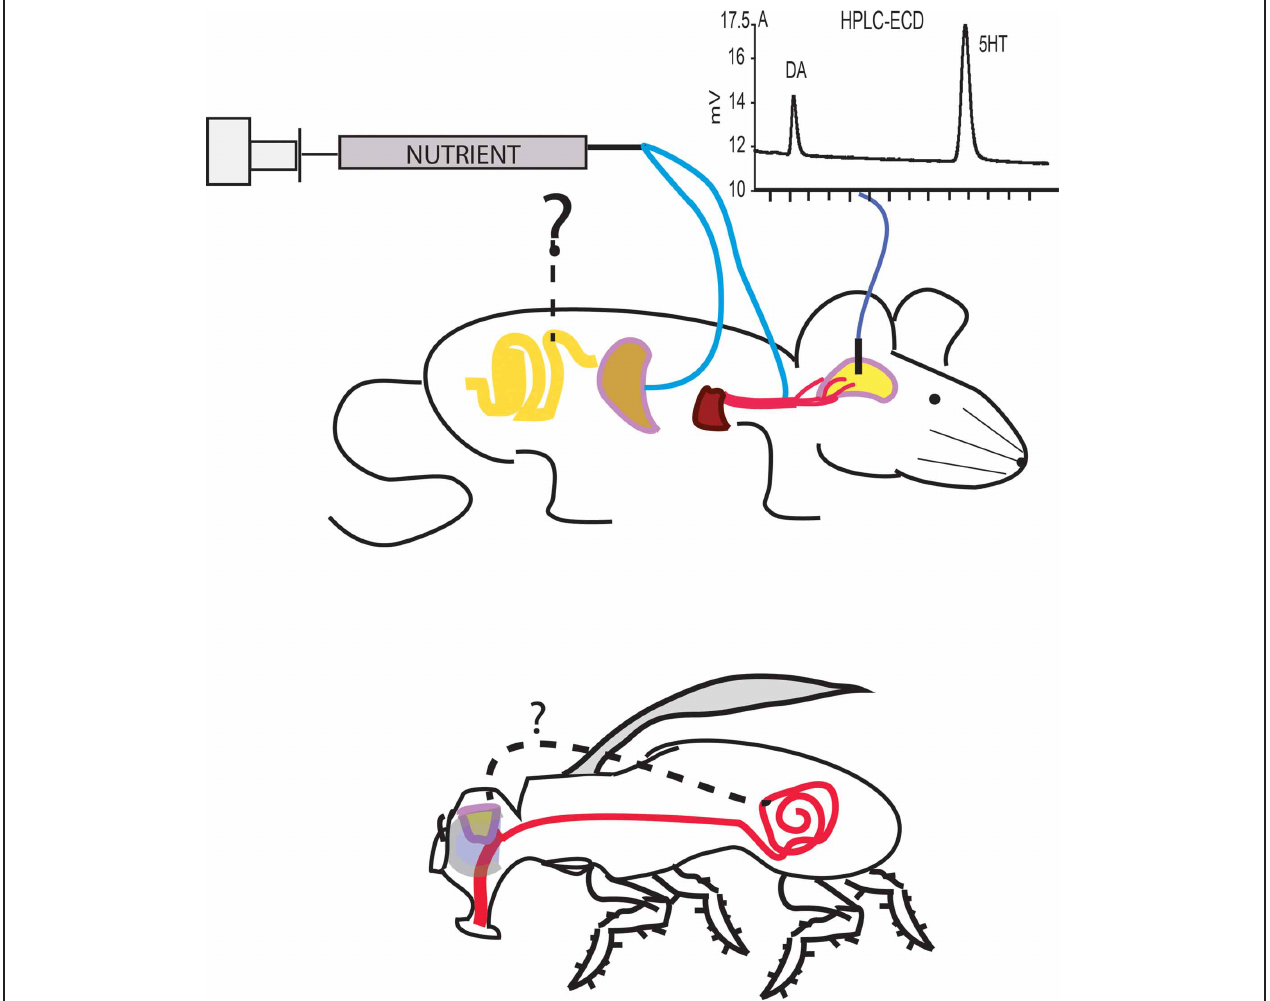
FIGURE 1 | Post-oral pathways modulating dopamine release. Infusions of nutrients into post-oral peripheral sites exert controlling actions over dopamine release, as measured from microdialysates collected from either the ventral or dorsal striatum. The figure illustrates the concept that different peripheral sites may produce stimulatory effects on dopamine release. Upper panel gastric injections of either non-gluconeogenic amino acids or sugars produce marked changes (reductions or increases, respectively) in extracellular dopamine levels in ventral striatum while isocaloric injections of glucose do increase dopamine levels in dorsal striatum (Ren et al., 2010). This finding establishes that stimulating the oral cavity is not required for stimulating dopamine release during nutrient intake. However, the relative contributions of gastric vs. intestinal sensing remain to be dissected because the effects if infusing nutrients directly into the intestine on dopamine release remain to be assessed (interrogation mark). Furthermore, jugular infusions of a glucose antimetabolite, 2-DG,